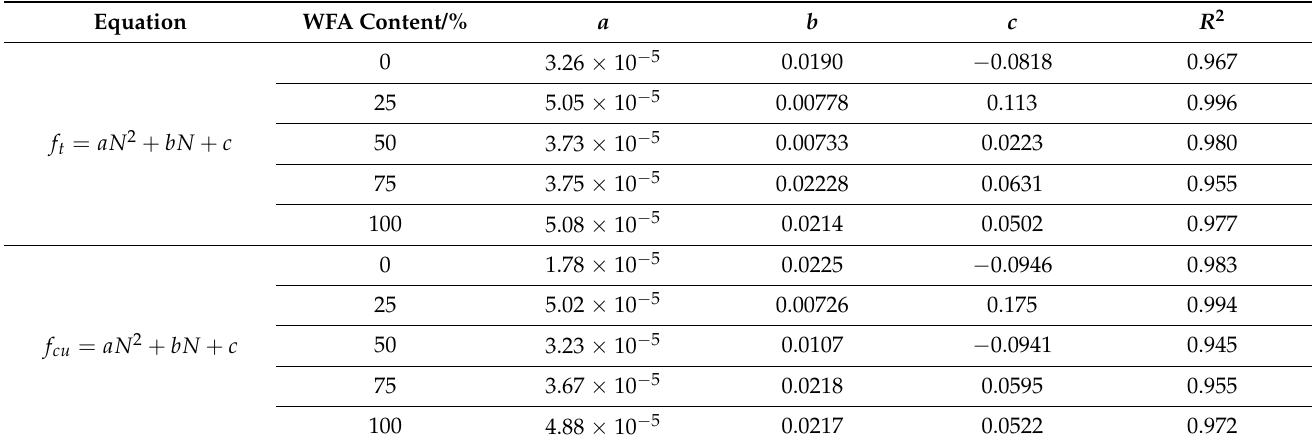
Table 5. Fitting parameters of mechanical strength loss rates and the number of NaCl freeze–thaw cycles ( N